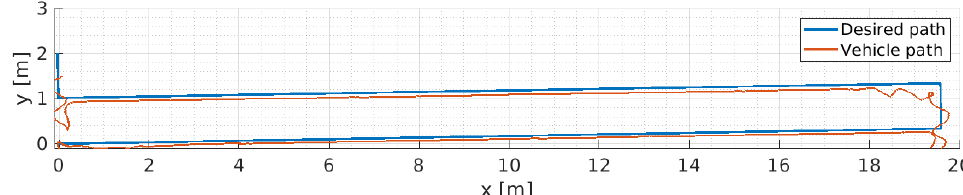
Figure 16. Simulation results for path following employing the modified controller with cross-current of 0.25 m/s.